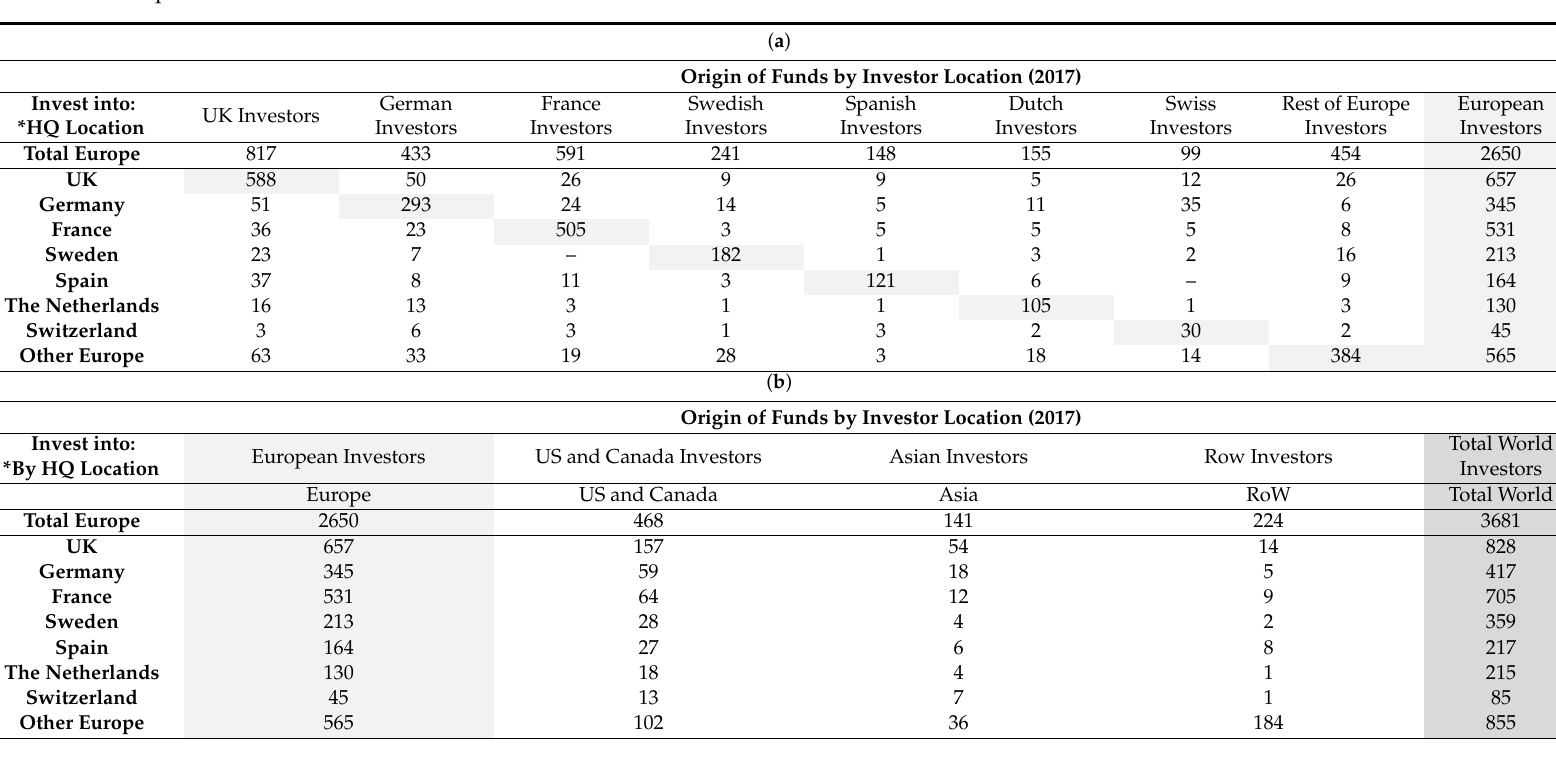
Table 1. ( a ) Number of VC rounds by location of investors and investees (2017) (Dealroom.co 2018). Most European investment rounds occur domestically. Of 817 rounds into European companies involving UK investors, 588 rounds were for UK-based companies. US investors are predominantly interested in the UK and Germany. ( b ) Of 828 total rounds in the UK in 2017, 157 rounds involved a North American (US and Canada) investor. This means roughly 20% of UK investment rounds have a US or Canadian investor. Of 828 total rounds in the UK in 2017, 657 rounds involved European investors. This means 79% of all UK investment rounds in 2017 had a European